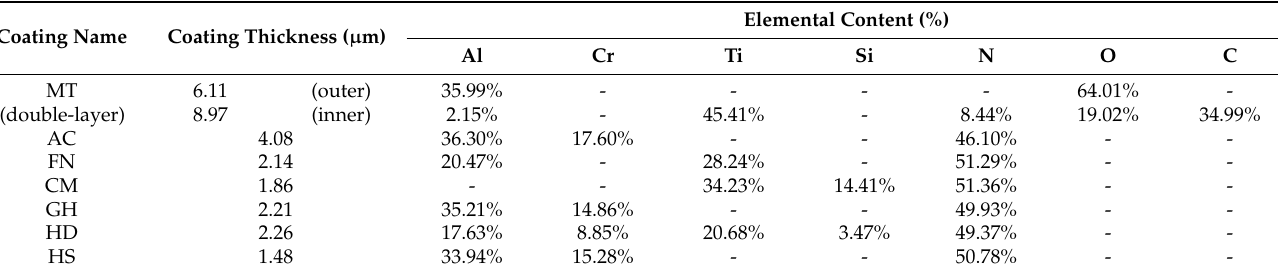
Table 4. Compositions of different types of